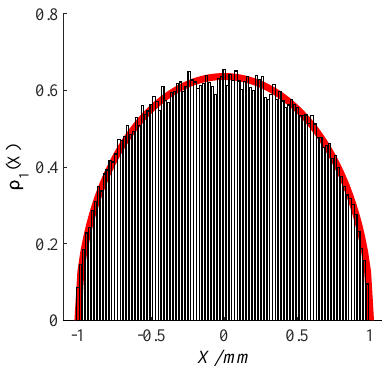
Figure 16. The PDF ρ 1 ( X ) along axis x .